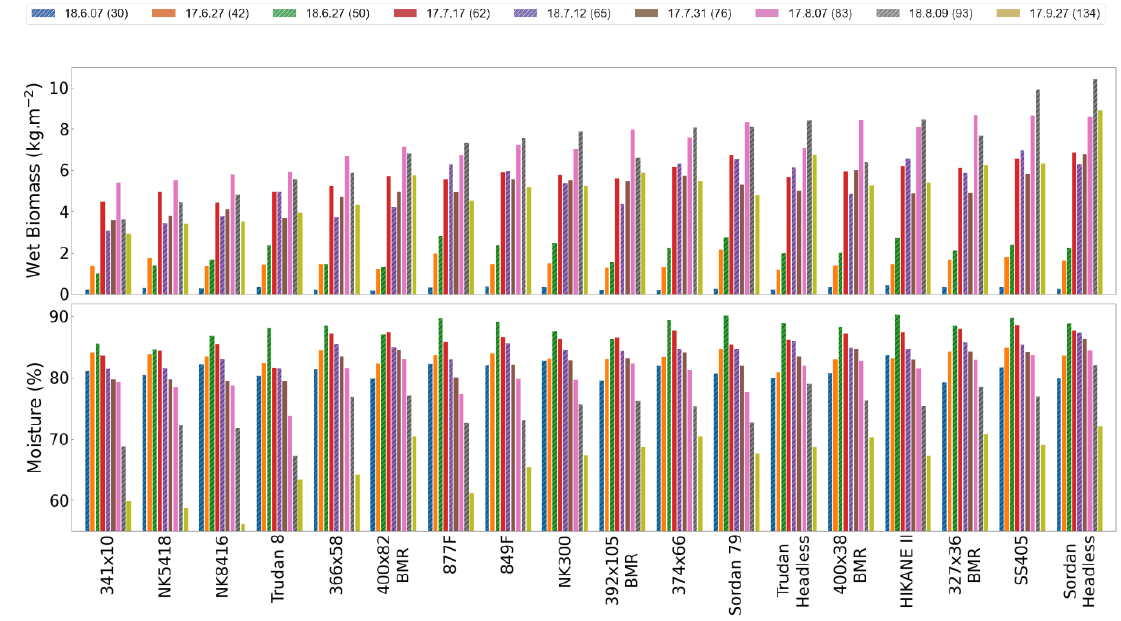
Figure 3. Ground reference data collected during the 2017 and 2018 growing seasons in the HyCal panels. For each variety, the data samples are sorted based on the day after sowing (DAS).